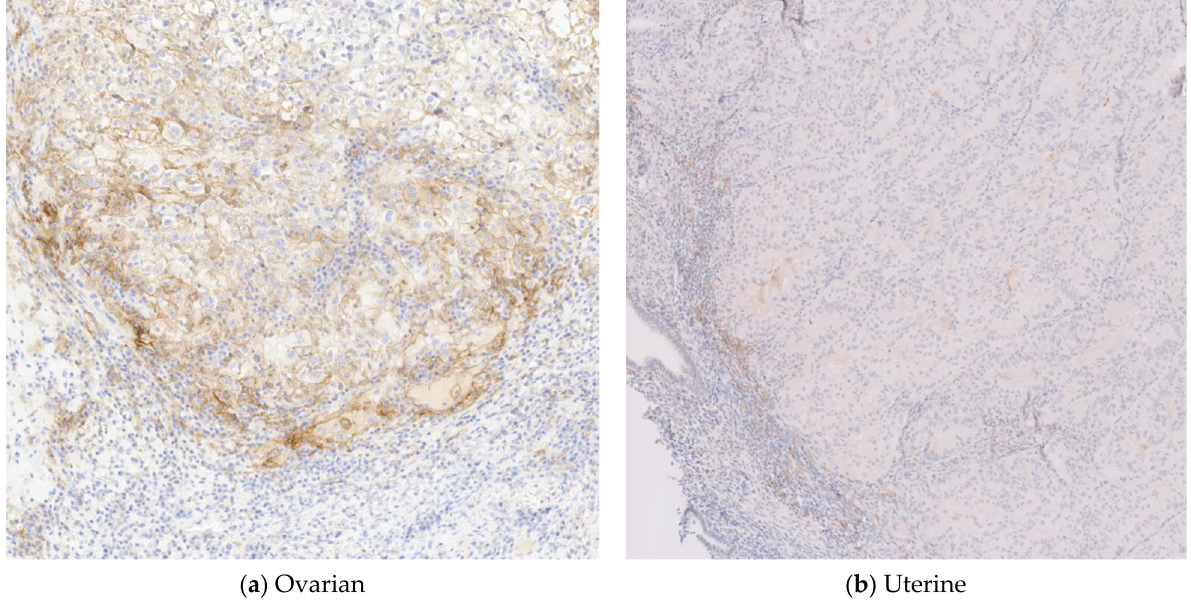
Figure 2. PD-L1 (22C3) expression of the ( a ) ovarian tumor showed 10% tumor cell positivity, while the ( b ) uterine tumor was negative.